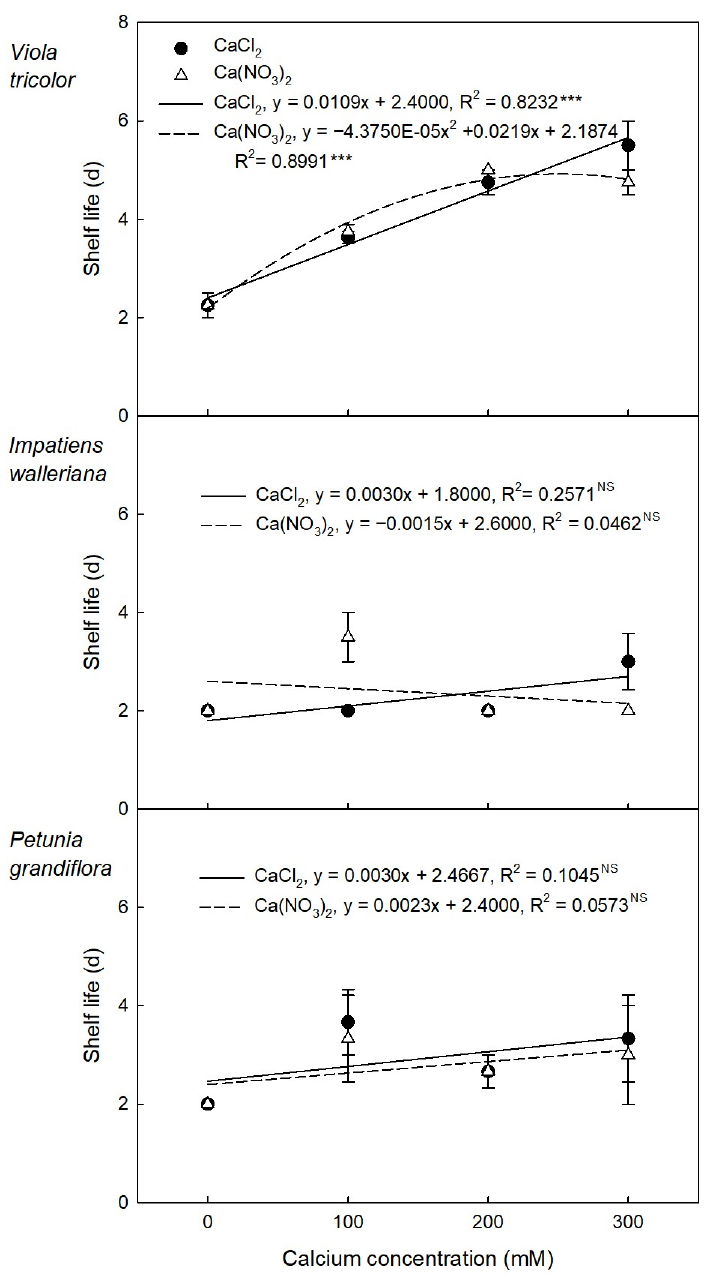
Figure 4. Influence of concentrations of CaCl 2 and Ca(NO 3 ) 2 on shelf life of V. cornuta (viola), I. walleriana (impatiens), and P. grandiflora (petunia) in drench application. Each data point represents the mean of shelf life, but the analysis was performed with all data (n = 4 for viola and impatiens and n = 3 for petunia). Bars represent standard error. NS, nonsignificant; ***, significant at p ≤ 0.001.